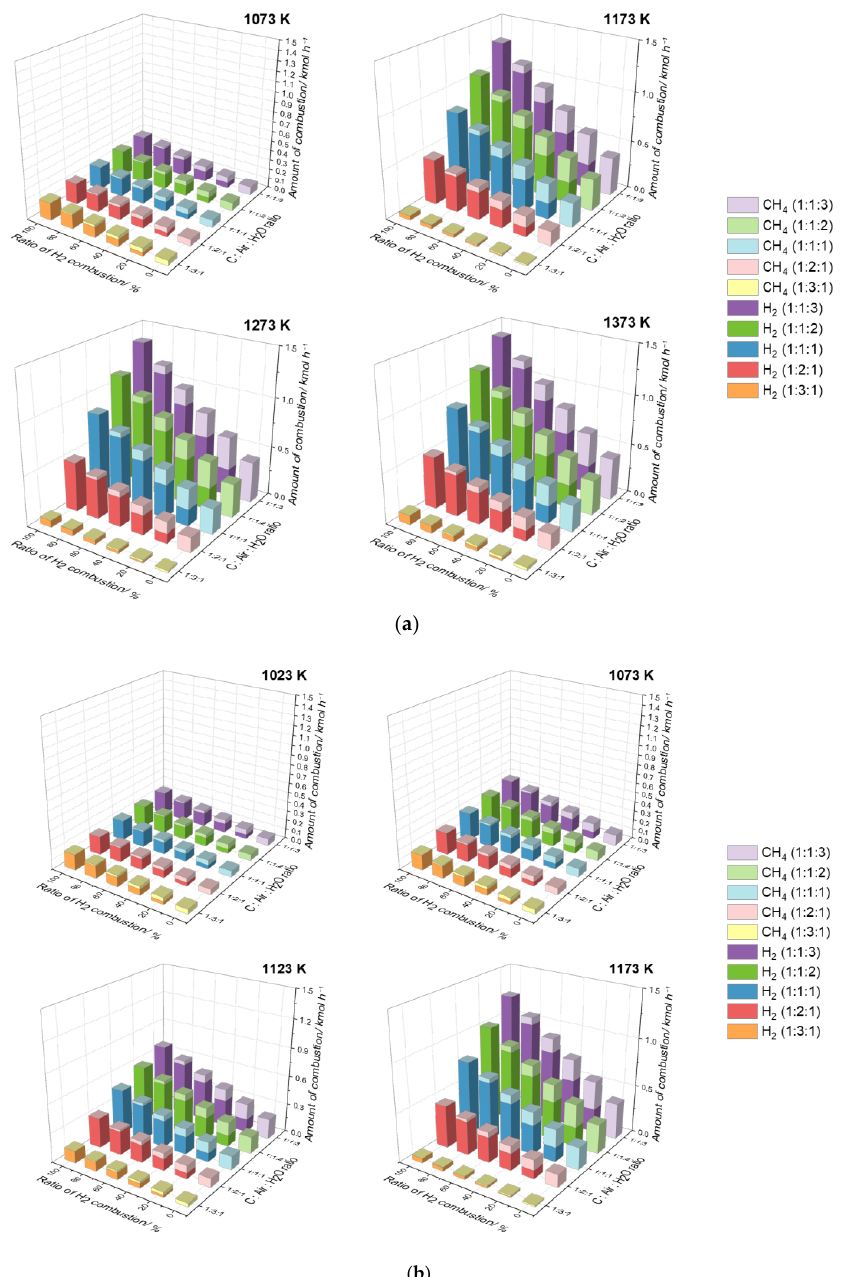
Figure 6. Amount of fuel (CH 4 and H 2 ) consumption for methane pyrolysis (MP) systems of thermal and catalytic methane pyrolysis with gasification and WGS reaction (( a ) TMPG-S3 and ( b ) CMPG-S4) in temperature of 1073–1373 K and 1023–1173